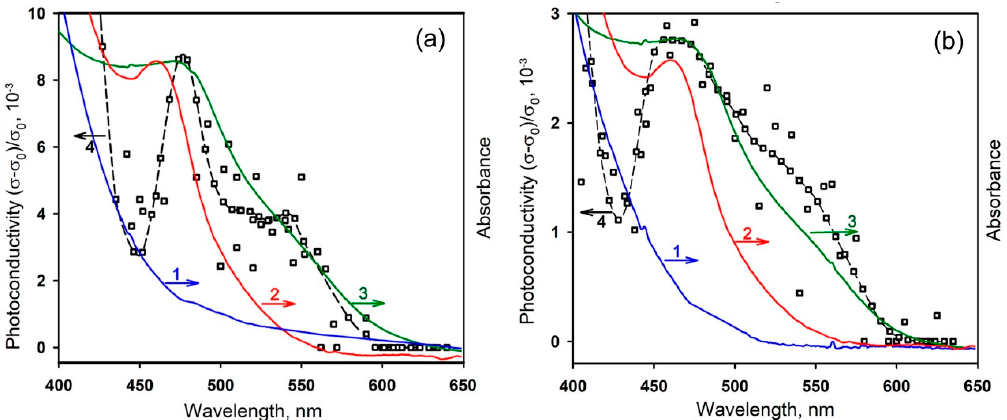
Figure 5. TG, DSC and MS curves of the SnO 2 Ru-TT hybrid sample. A comparison of optical and photoelectrical properties of pure semiconductor matrixes, Ru-TT complex and hybrid materials is shown in Figure 6. The greatest influence of Ru-TT complex on the optical properties of composites appeared in visible spectral range. In both hybrids, the intensive absorption band was observed at λ max = 472 nm, due to the presence of organic sensitizer. As compared with the spectrum of Ru-TT complex, the maximum of the absorption edge was shifted to the long-wavelength region by about 10 nm. Even though the constituent components of hybrids do not have absorption bands at λ > 500 nm, the spectra of sensitized materials exhibited a broad shoulder in the long-wavelength region around 510–620 nm. This can be caused by the aggregation of Ru-TT molecules on the surface of the semiconductor oxides [57].